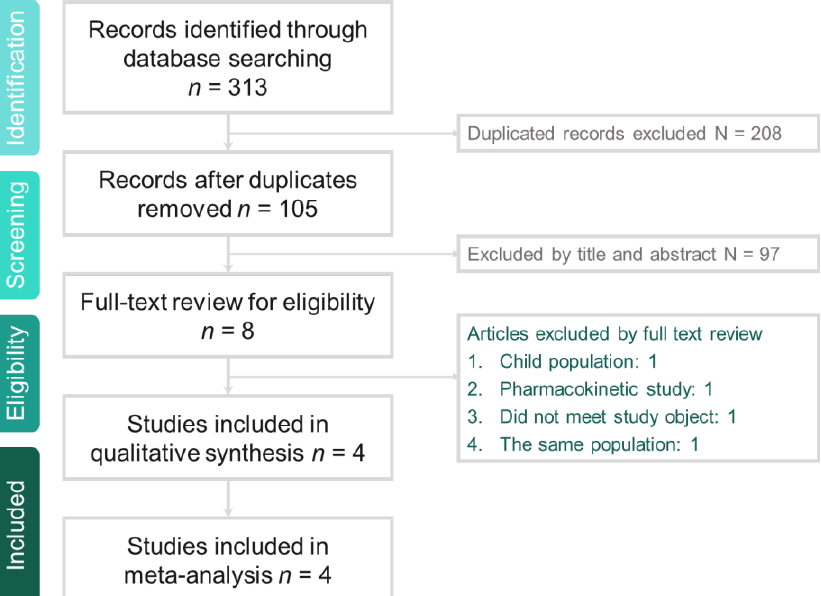
Figure 1. The algorithm of study